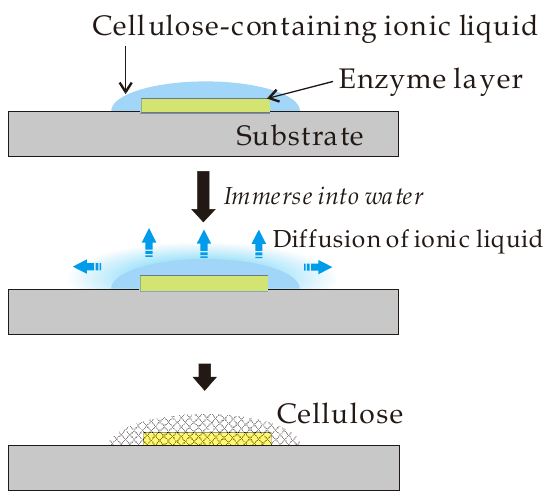
Figure 6. Preparation method of cellulose-covered enzyme membrane [75]. Cellulose-containing ionic liquid coated the enzyme layer on the substrate, and whole substrate was immersed in water. During immersion, the ionic liquid diffused into the water. As a result, cellulose was deposited on the enzyme layer. Meshes of cellulose fibers have smaller pores compared with the diameter of the enzymes and larger pores compared to enzyme substrates.